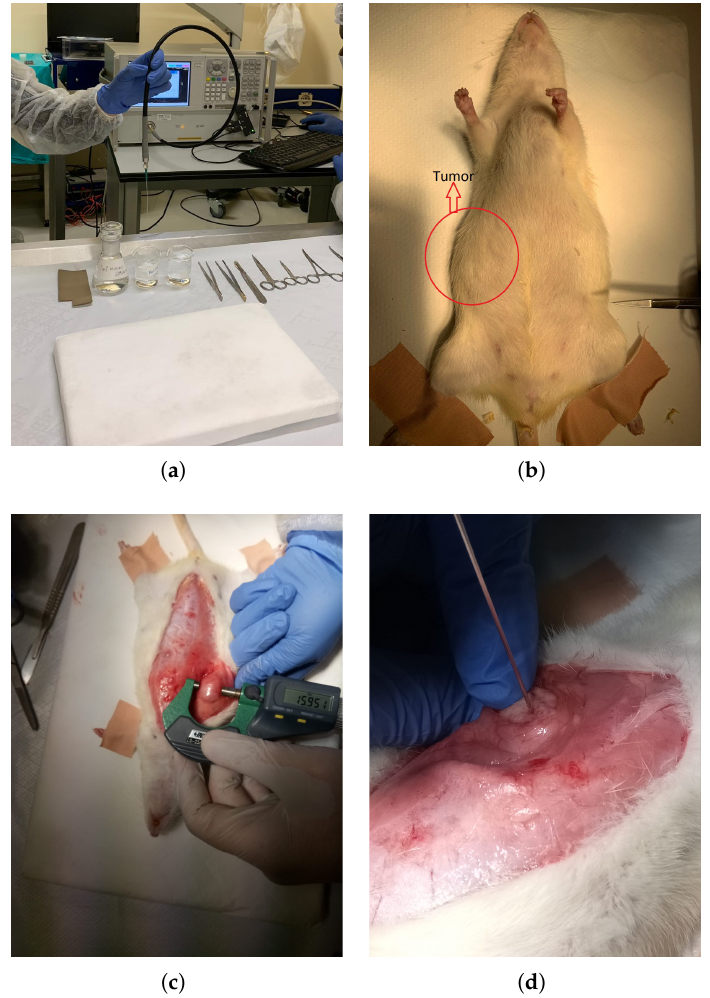
Figure 1. Protocol followed during in vivo dielectric property measurements of rat mammary tissues: ( a ) Measurement setup along with the network analyzer, RF cable, and open-ended coaxial probe; ( b ) A picture of the tumor gross view; ( c ) Exposed rat benign tumor with calliper measurement; ( d ) Tumor measurement with open-ended coaxial probe.